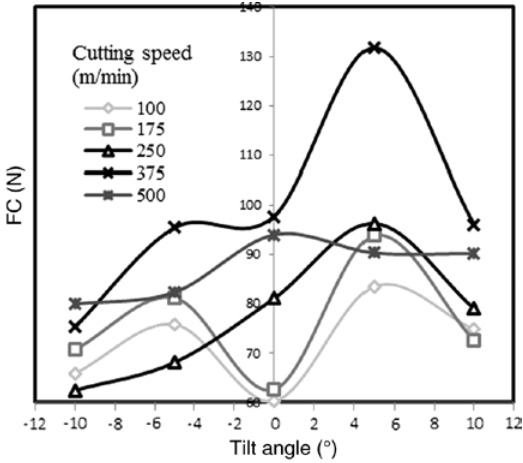
Figure 10: Effect of lead angle on the cutting force at cutting speed 250 m/min (feed 0.063 mm/rev).